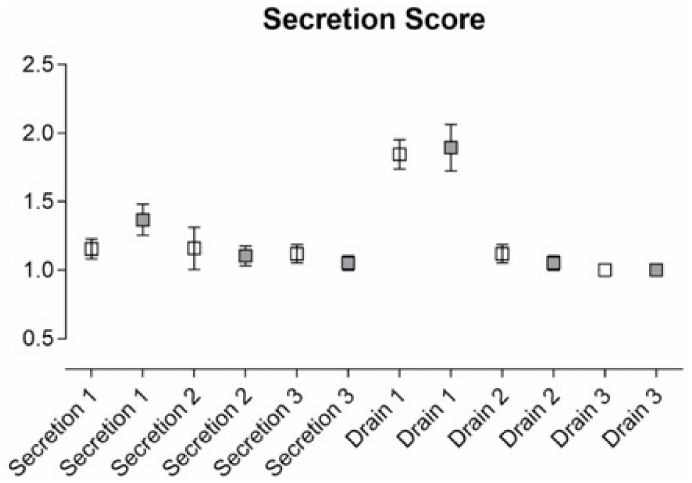
Figure 2. Secretion quantity score from wound and drainage site over the three observation points. Shown is the mean with error bars indicating 95% confidence interval.